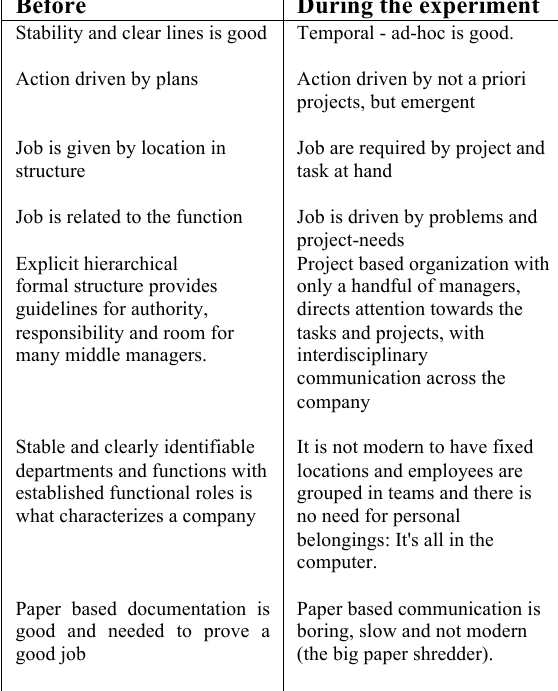
Table 1 . Analysis of the meaning of organizational